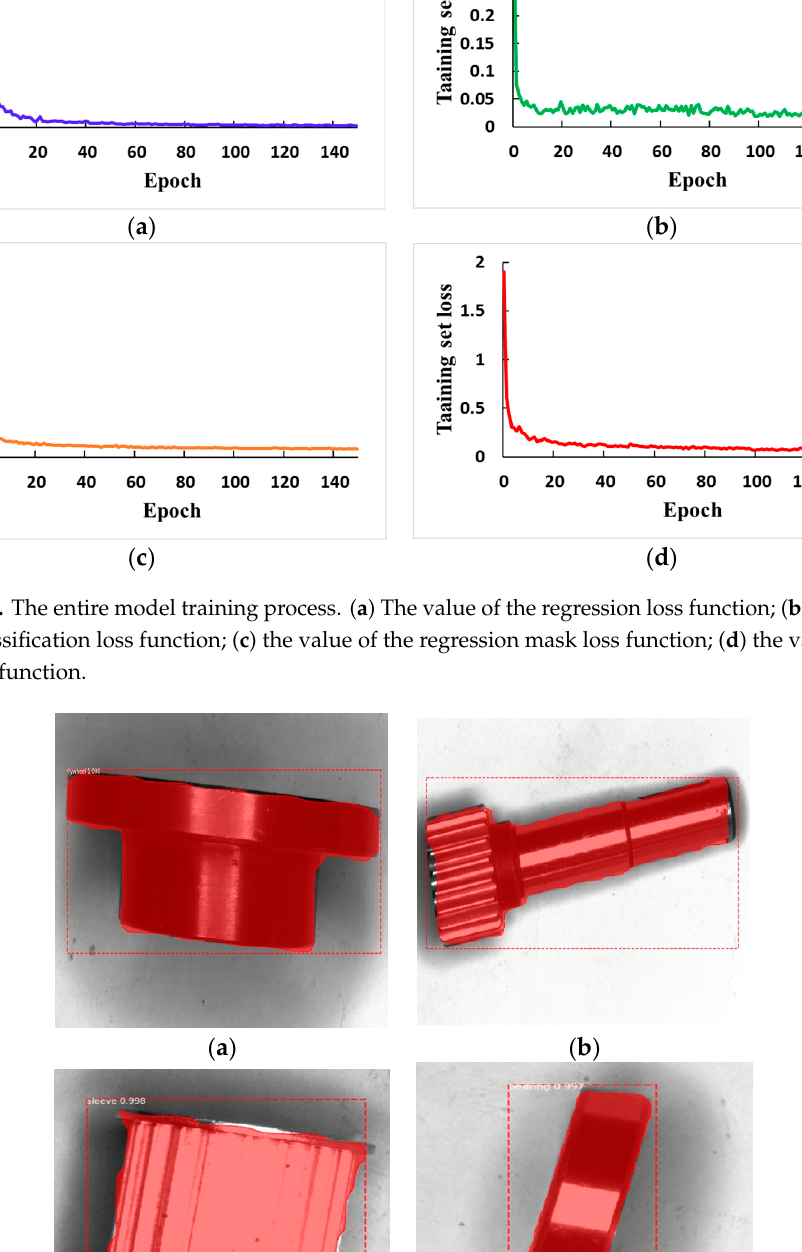
Figure 12. The entire model training process.